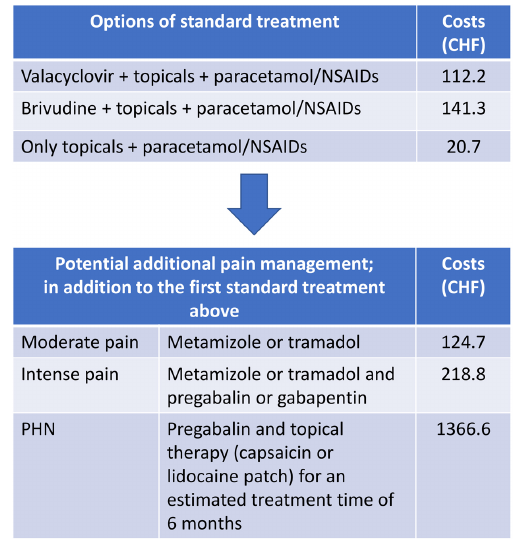
Figure S1: Cost estimates of the herpes zoster-related drugs in an outpatient setting. As many patients with post-herpetic neuralgia (PHN) were referred to us for the treatment of PHN only and it was unclear from our documents whether or not they had been treated with basic antiviral standard treatment, we did not include the ba- sic antiviral standard treatment costs for this estimation in our pa- tients. NSAIDs = Ibuprufen,